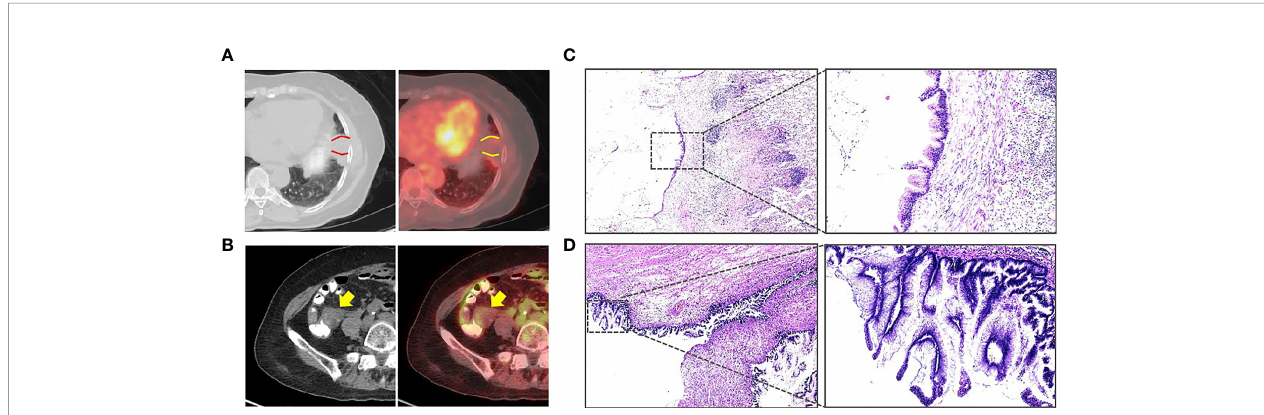
FIGURE 1 | (A) PET/CT showing that an effusion can be seen in the oblique fi ssure of the left lung, and a nodular thickening was also seen near the pleura in the lower lobe of the left lung (between the two curves, standard uptake value (SUV) = 2.08). (B) PET/CT showing that a cystic mass can be seen in the ileocecal area (arrow, SUV = 2.28). (C) The pulmonary tumor revealed mucinous adenocarcinoma (H&E). (D) The postoperative pathology revealed a low-grade appendiceal mucinous neoplasm